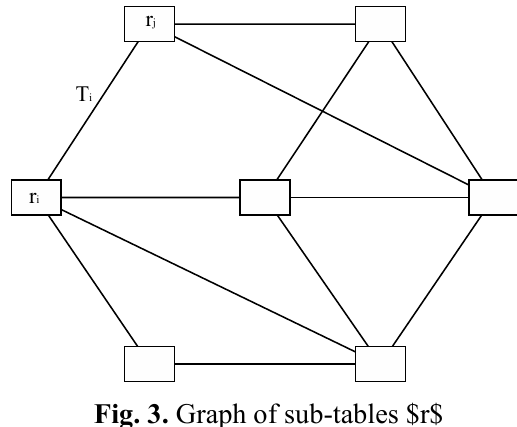
Fig. 3. Graph of sub-tables